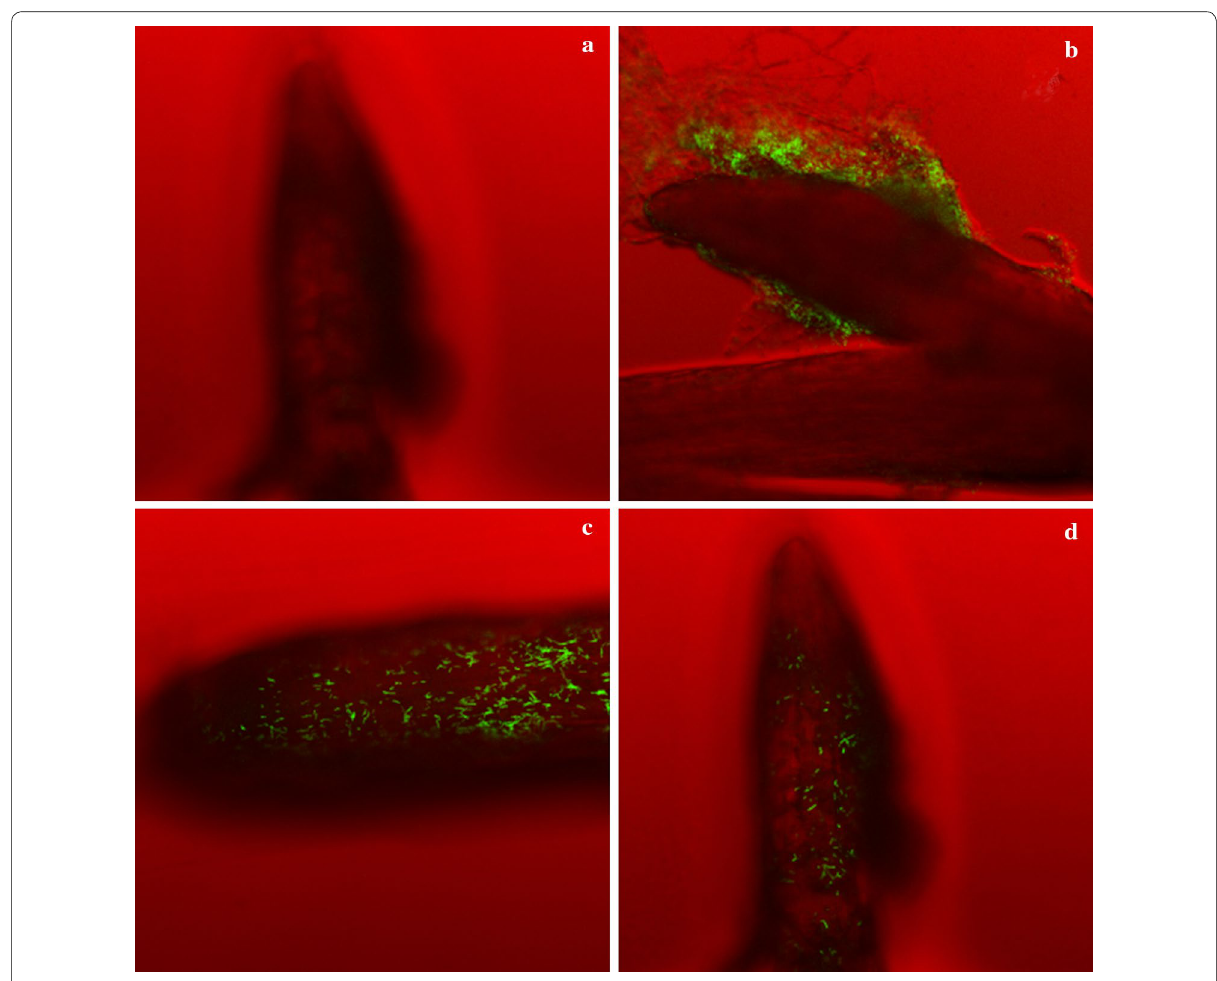
Fig. 2 Qualitative analysis of SQR-21- gfp cells colonized on watermelon roots. a Without inoculation of SQR-21- gfp to the watermelon roots as a control; after b 1, c 3, and d 5 days, SQR-21- gfp colonized on the watermelon